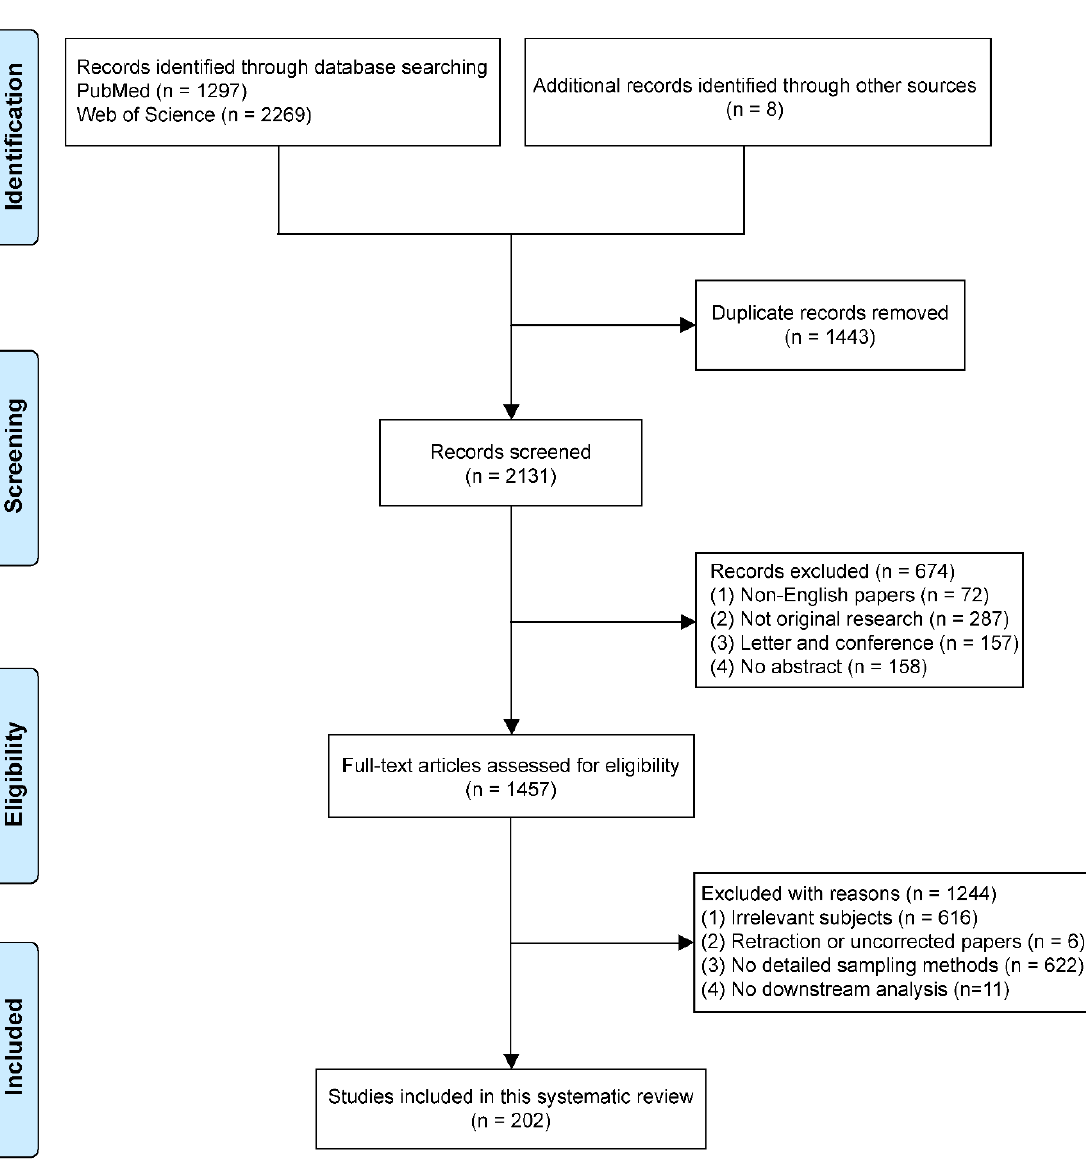
Figure 1. Flow diagram of literature search.